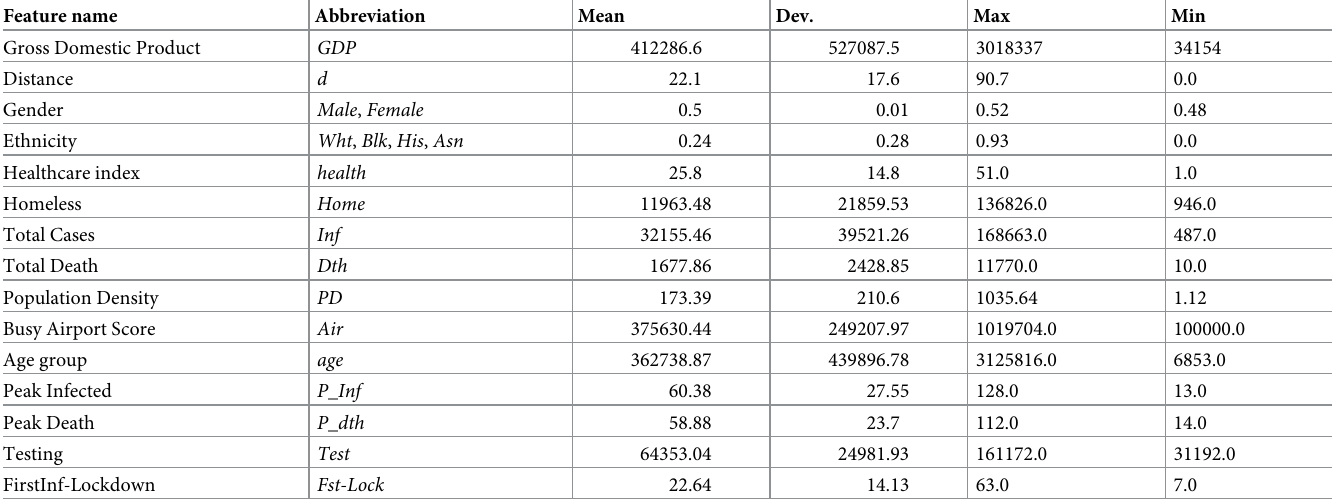
Table 1. Summary of features and their statistics (i.e., mean, standard deviation (dev.), maximum (max.) and minimum (min.)). The features in the order shown under “Feature name” are: GDP, inter-state distance based on lat-long coordinates, gender, ethnicity, quality of health care facility, number of homeless people, total infected and death, population density, airport passenger traffic, age group, days for infection and death to peak, number of people tested for COVID-19, days elapsed between first reported infection and the imposition of lockdown measures at a given